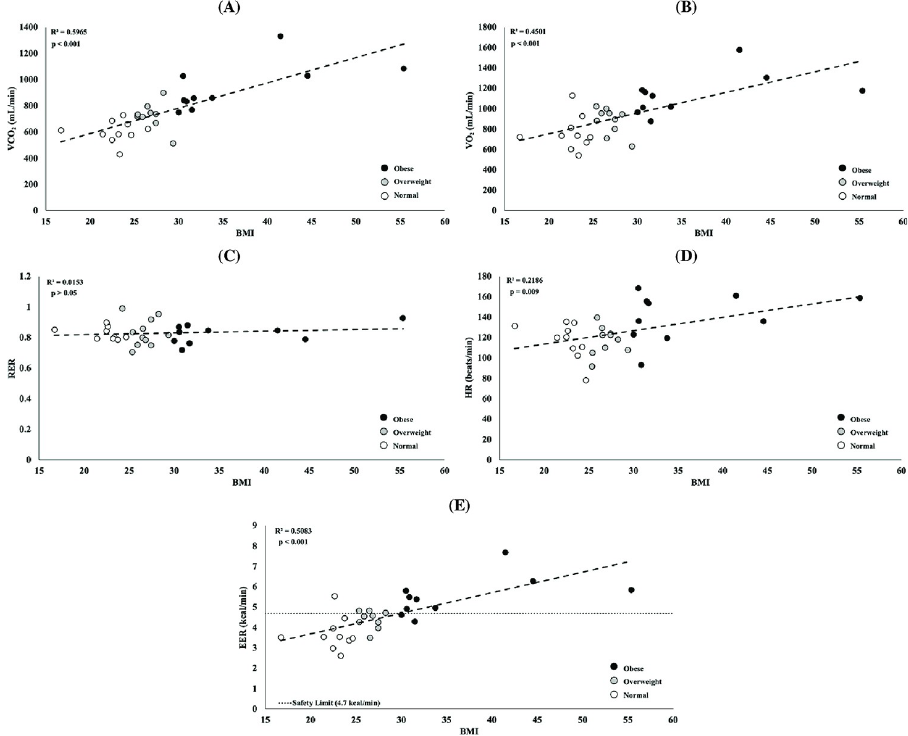
Fig 3. Relationships between metabolic variables and BMI. Each circle represents a subject, and the colors of the circles correspond to the BMI of that subject: black is obese, grey is overweight, and white is normal. An average steady state value for each metabolic variable was graphed versus each subject’s BMI. Dashed lines reflect the linear regressions, and R 2 and p-values are provided for the data of each metabolic variable. The figure represents the relationship between a subject’s BMI and average steady state: (A) VCO2; (B) VO2; (C) RER; (D) HR; and (E) EER, with the dotted line representing the safety limit (4.7 kcal/min).